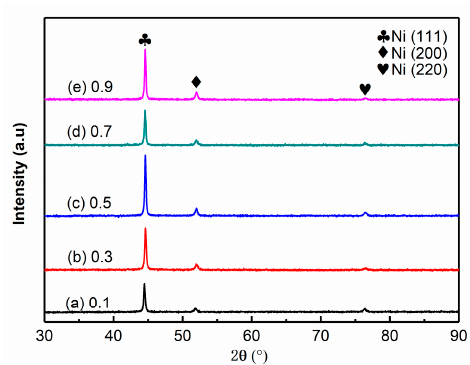
Figure 7. XRD patterns of Ni–Co–BN (h) nanocomposite coatings with varying duty cycles: ( a ) 0.1, ( b ) 0.3, ( c ) 0.5, ( d ) 0.7, ( e ) 0.9.